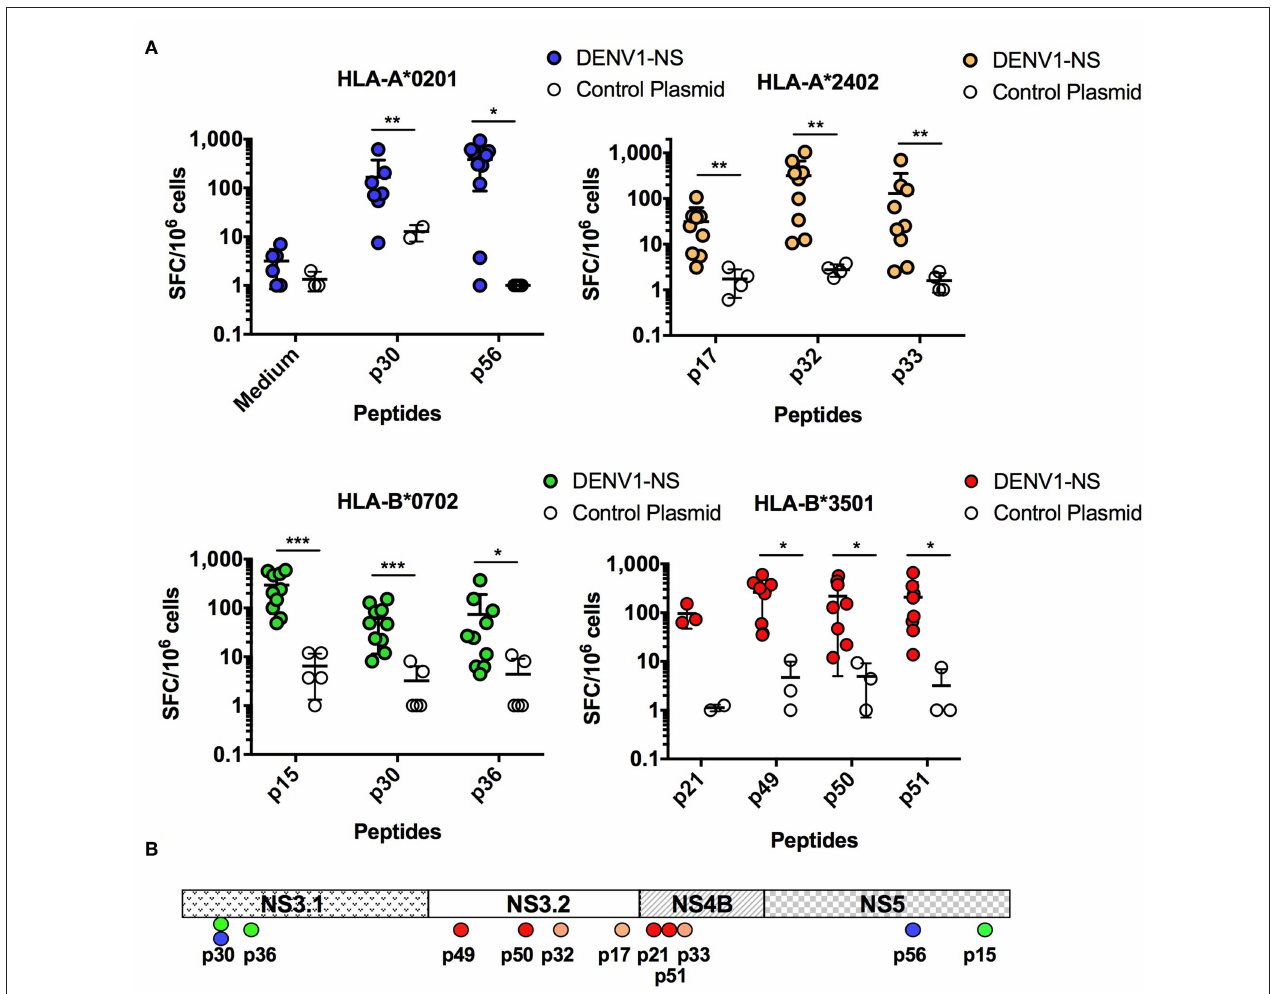
FIGURE 2 | Quantification of the T cell responses in HLA-A*0201, -A*2402, -B*0702, and -B*3501 transgenic mice by ELISpot assay. (A) Three independent experiments were performed, in which a total of 10 and 4 HLA-A*0201 transgenic mice received the DENV1-NS construct and the control plasmid (CT), respectively, 9 and 4 HLA-A*2402 transgenic mice received the DENV1-NS construct and the control plasmid, respectively, 10 and 5 HLA-B*0702 transgenic mice received the DENV1-NS construct and the control plasmid, respectively, and 8 and 3 HLA-B*3501 transgenic mice received the DENV1-NS construct and the control plasmid, respectively. All the animals were immunized by intradermic injection (100 µ g DENV1-NS or control plasmid) followed by in vivo electroporation. Two immunizations were performed at 3-week interval, and spleen cells were tested for IFN- γ secretion by ELISpot 10 days after the second injection. Individual mice were tested in parallel with different peptides at 2 µ g/ml and with concanavalin A (ConA) at 5 µ g/ml, final concentration. Lines represent mean and SEM. Differences between mice immunized with the DENV1-NS construct and the control plasmid were evaluated using non-parametric Mann-Whitney U-test (* p < 0.05, ** p < 0.01, *** p < 0.001). (B) Schematic representation of the T cell epitopes from the DENV1-NS poly-epitope, which induce a significant T cell response in HLA transgenic mice. NS3.1, NS3.2, NS4B, and NS5 represent the 4 antigenic regions selected in the DENV1-NS